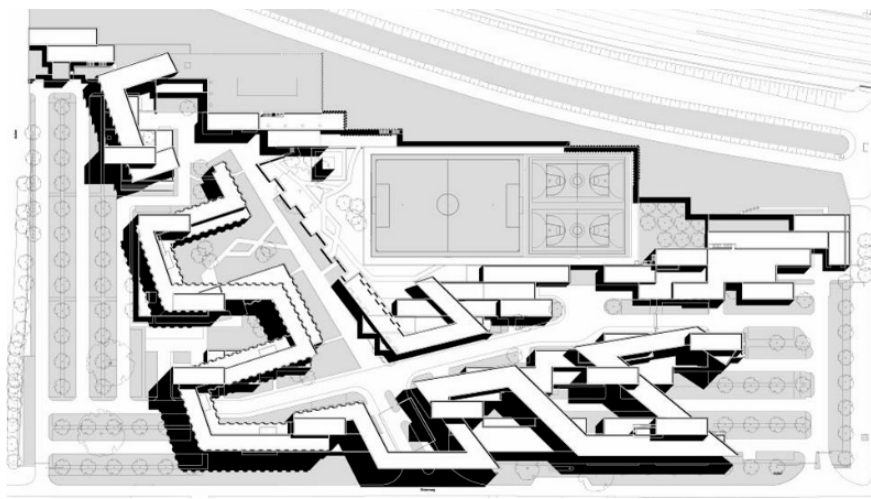
Figure 2. The concept of compact urban development for the Royal Military Police District Schiphol Danemark; source: Zvi Hecker Archive, Berlin, 2005.